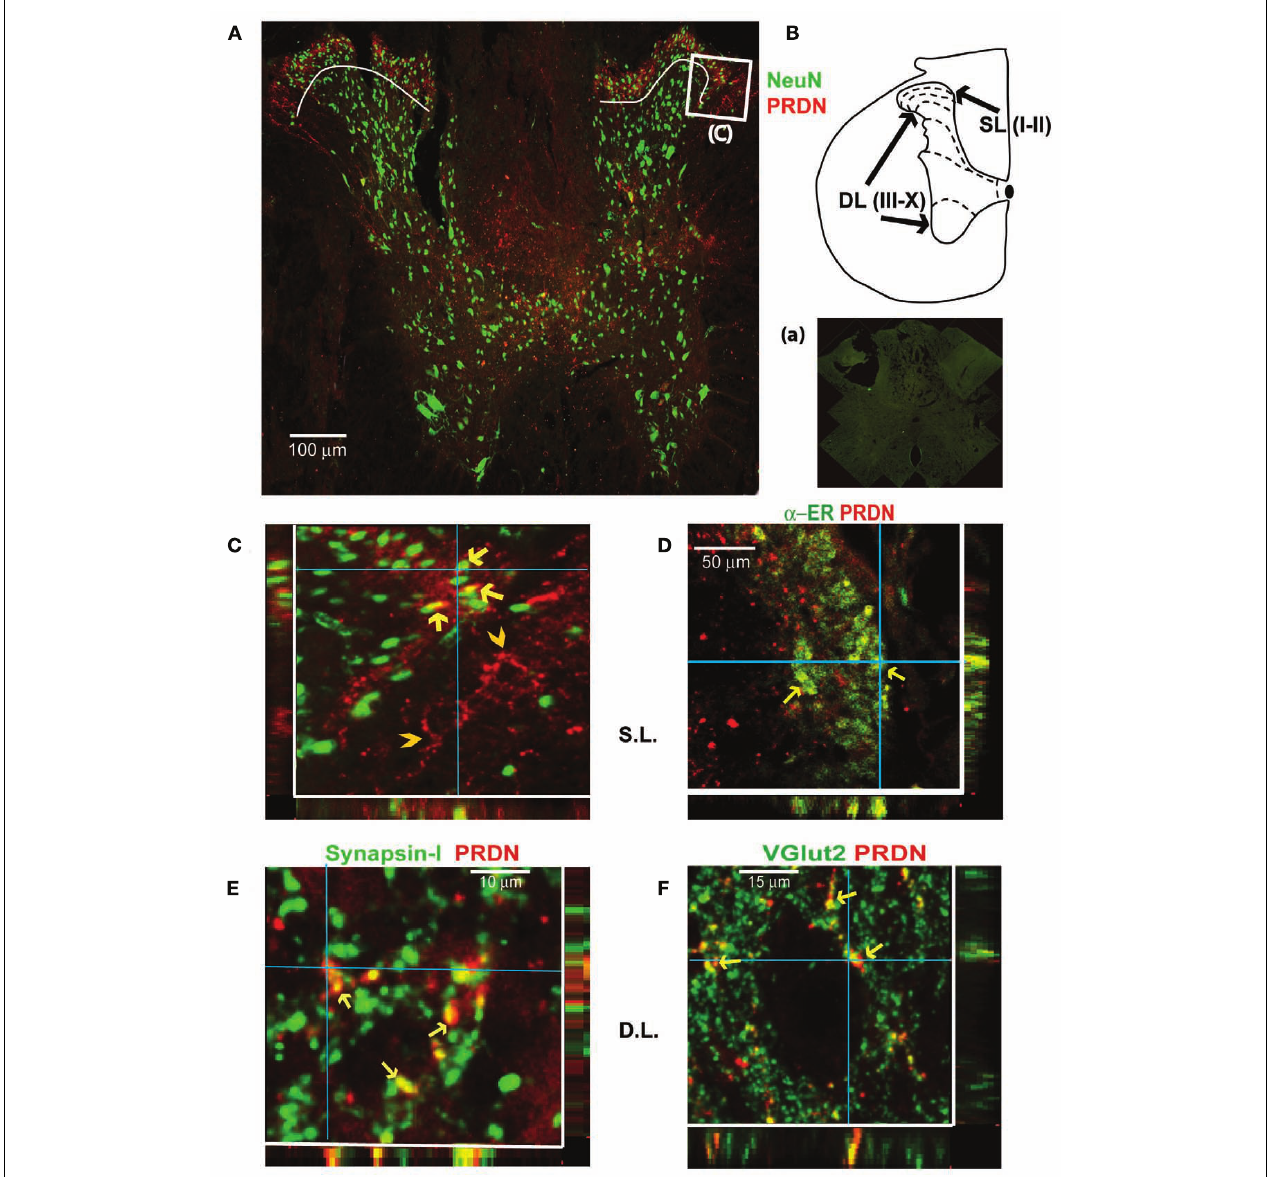
(yellow arrowheads) suggestive of expression in axons. (D) Shows the co-localization of PRDN and estrogen receptor α (ER α ) in SL (yellow arrows). Image (E) shows the co-expression of nerve terminal marker, synapsin I within the PRDN-IR puncta (shown in deep laminae (DL), yellow arrows). (F) PRDN-IR puncta is shown to co-express glutamatergic marker vesicular glutamate transporter 2 (VGLUT2). Image in (a) shows a typical absence of specific labeling in a section atT7 from SCI animals with placebo, when primary antibodies (PRDN and NeuN) were substituted with non-immune sera from the respective host animals. Images shown are typical of sham, SCI + placebo and SCI + EB rats ( n = 4–5 each). For consistency, only images from the SCI + placebo group of male rats are shown. Co-localizations [yellow arrows in (C,F) ] are also seen in XZ andYZ planes passing through the blue lines. Abbreviations are as in Figure 1